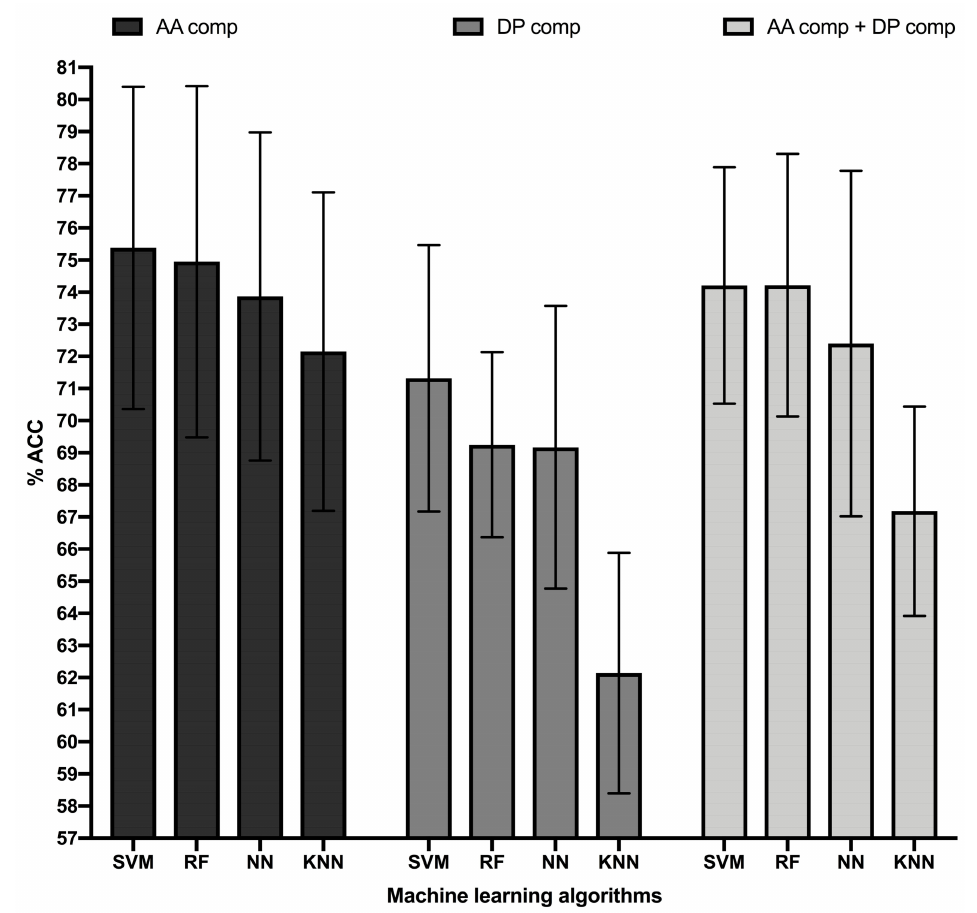
Figure 1. Accuracy top-performing ML models classifying B cell epitopes. Figure shows the accuracy in percentage (% ACC, Y -axis) of the top-performing ML models ( X -axis) trained in B cell epitope sequence features consisting of amino acid (AA) composition (black bars), dipeptide (DP) composition (dark grey bars), and combination of amino acid and dipeptide composition (light grey bars). ML models consisted of Random Forest (RF), Support Vector Machine (SVM), K-Nearest Neighbor (KNN), and Neural Network (NN) obtained with the following parameters: RF, 450 single decision trees; SVM, RBF Kernel with a complexity parameter of 4.0 and a gamma value of 0.4, KNN, 10 neighbors; NN, Multilayer Perceptron with a single hidden layer of 11 nodes and a learning rate of 0.01. Accuracy was computed in 10-cross validation experiments repeated 10 times and error bars represent standard